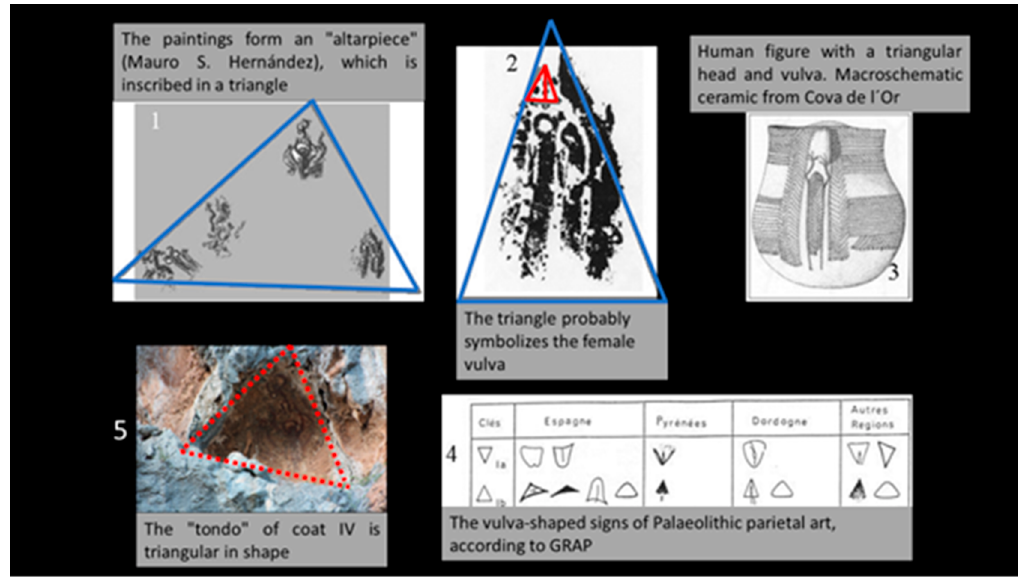
Figure 21. Evidence that the triangle is a symbol of the female vulva.